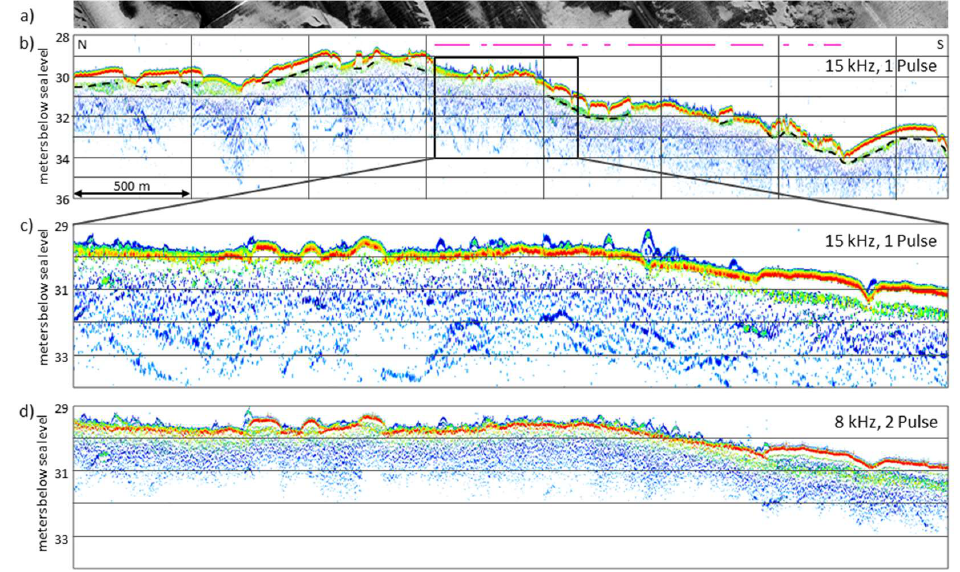
Figure 6. Exemplary pSES profile (15 kHz, 1 pulse) crossing the case study area from North to South ( b ) with corresponding sidescan backscatter data ( a ). Low sidescan backscatter data (e.g., fine sands) are represented by greyish colors and high backscatter (e.g., coarse grained sediments) by darker colors. Sediment echo sounder data indicate that coarse sediments are partly covered by fine sands. The boundary between the two facies is marked by the dashed line in ( b ). The purple lines mark areas with hyperbolas. ( c ) Zoom of ( b ). ( d ) Same section as c recorded with 8 kHz and 2